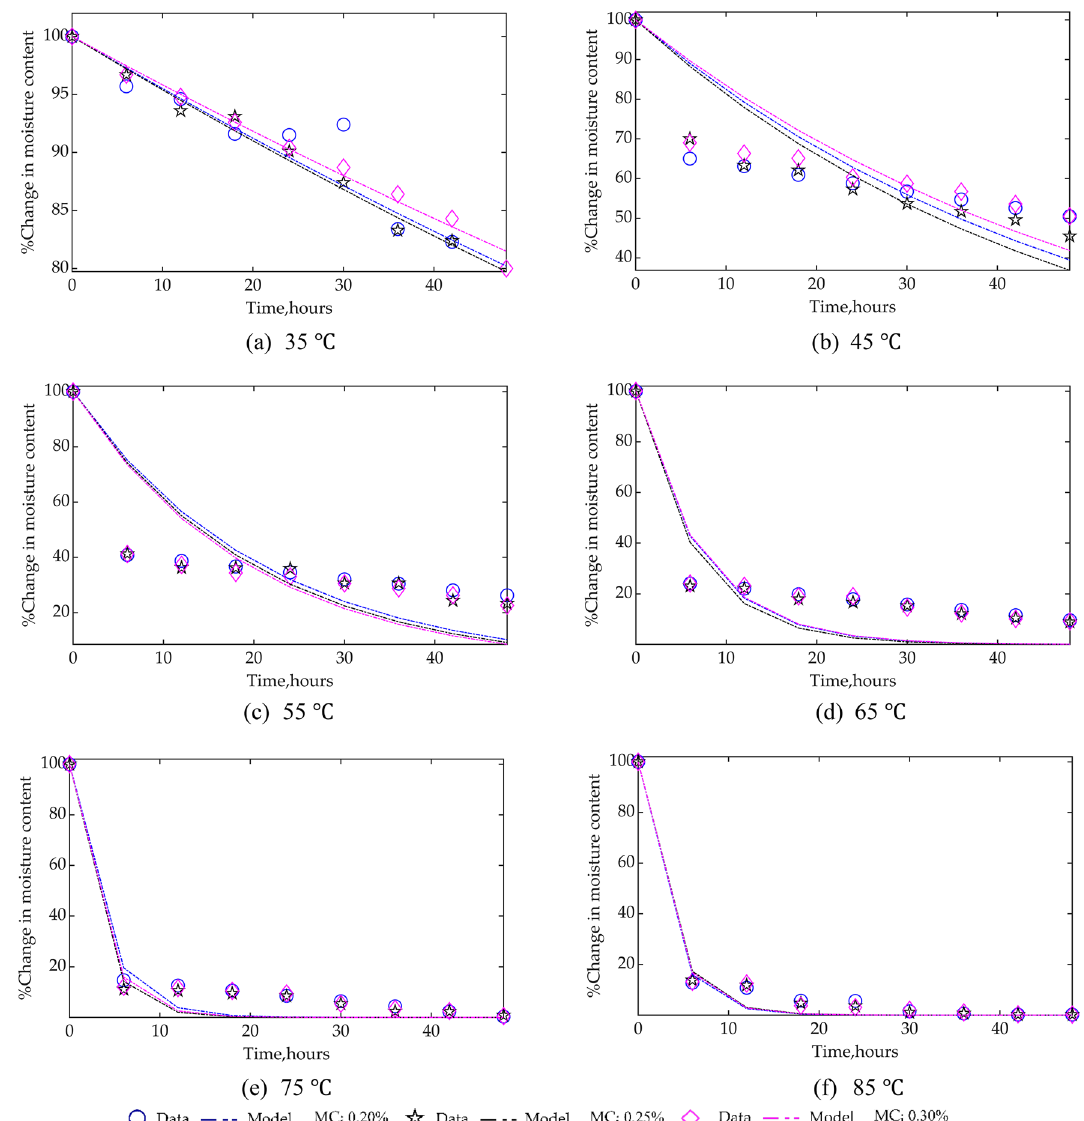
Figure 6. Comparison of experimental data and kinetic model of CPO MC at different temperatures and MC i .